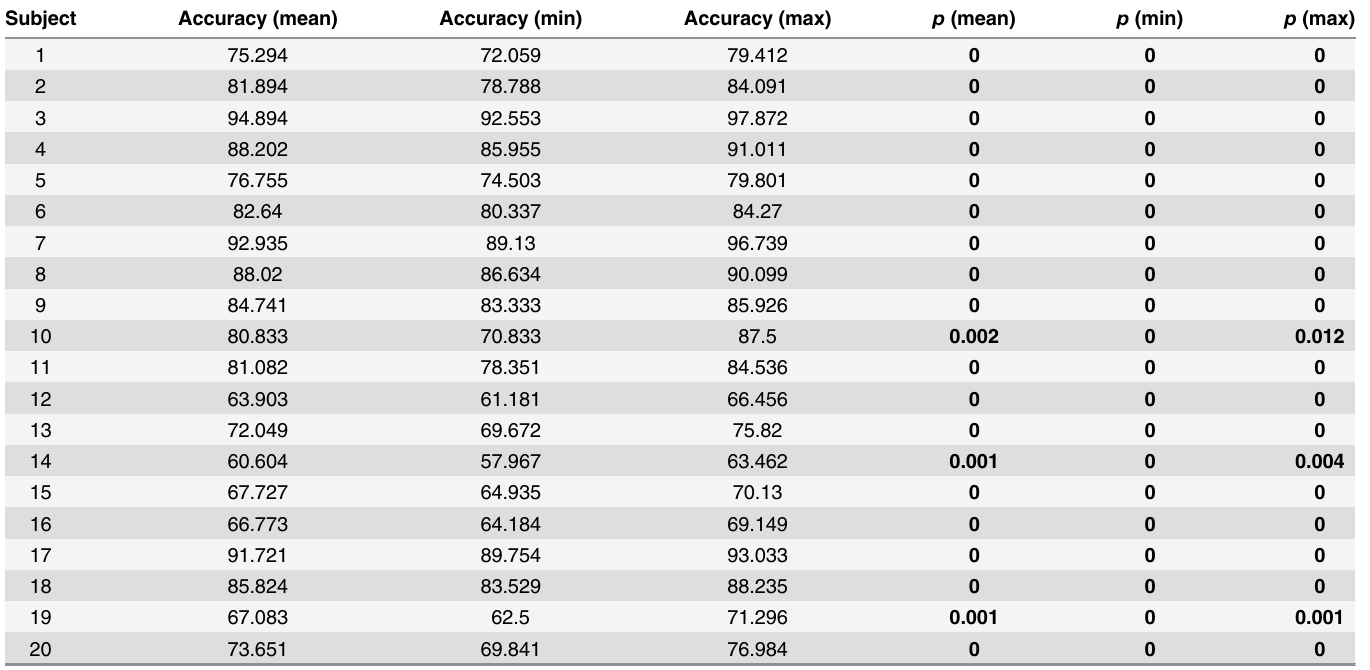
Table 2. Results Flanker Task Ne